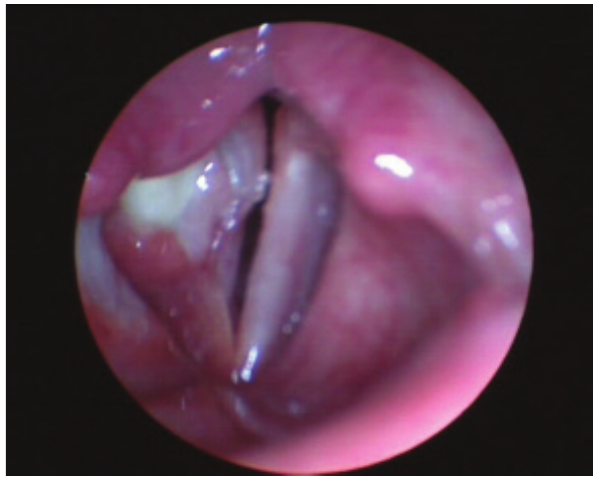
Figure 2: Chest CT scan: comparing two CT scan images, negative dynamics are seen in the latter, some of the nodes in the apical lobe of the left lung are enlarged and new ones had